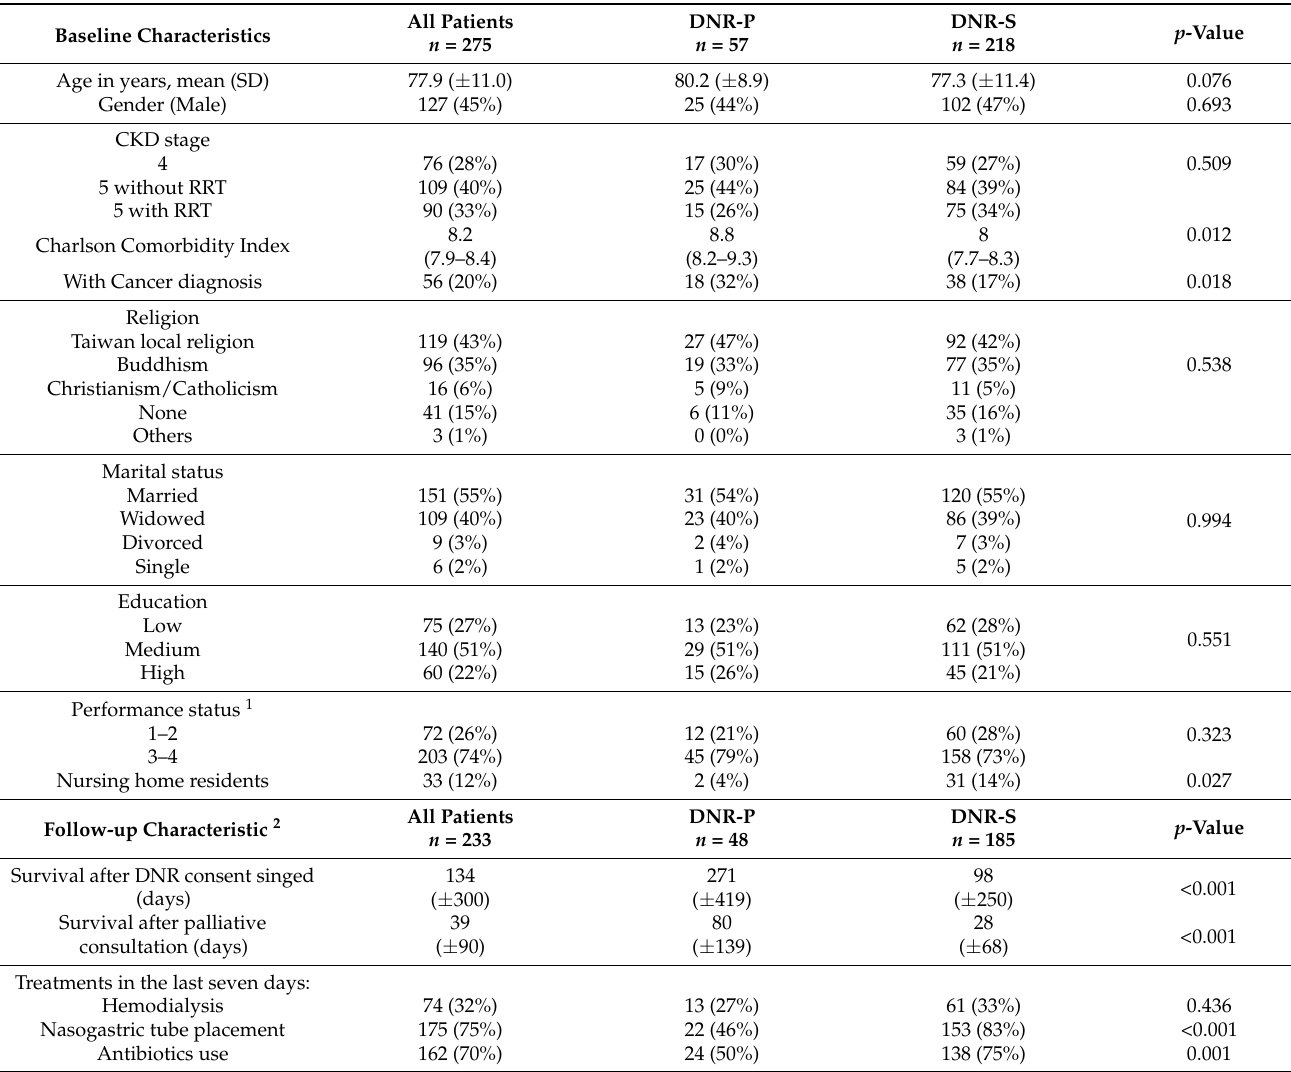
Table 1. Baseline and follow-up clinical characteristics in patients with advanced kidney disease receiving palliative care consultation during January 2014–December